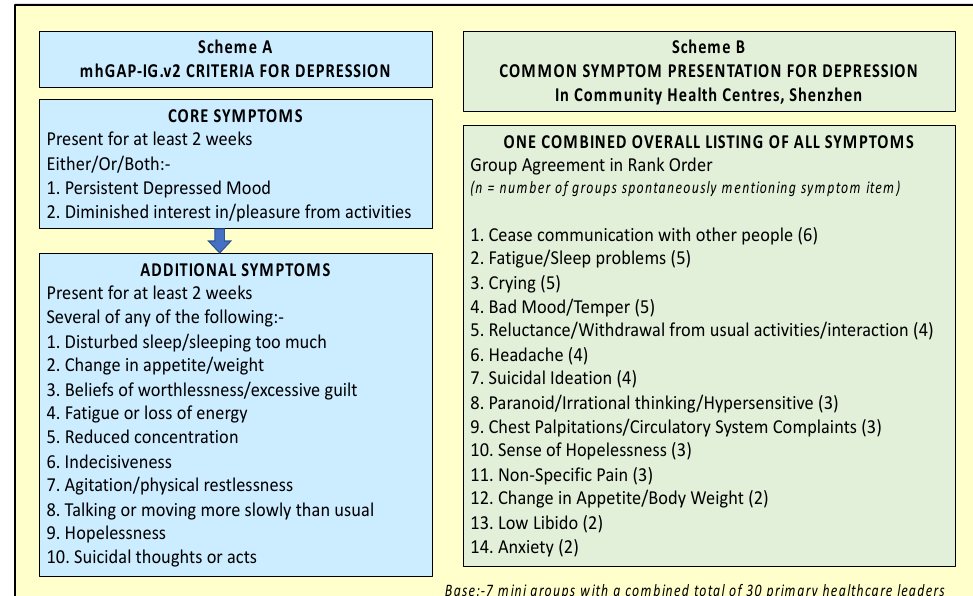
7 of 17 Figure 1. Geographic distribution of participants and community healthcare centres. 3.2. Primary Healthcare Leaders’ Conceptualisation of Depression The assessment section of mhGAP-IG.v2 was developed taking into account the gen-